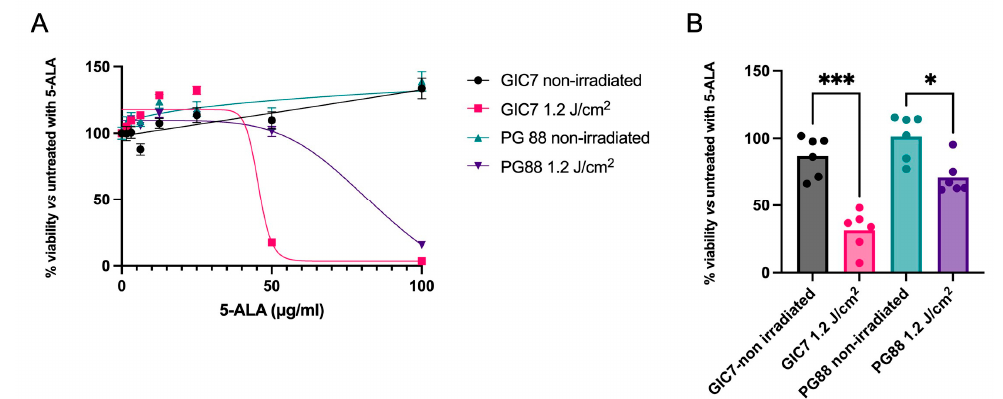
Figure 7. Comparison of GIC7 and PG88 cells’ behavior under 5-ALA treatment (0–100 µg/mL) and irradiation. ( A ) Dose-response comparison of adherent cell cultures with different 5-ALA concentrations treated with 1.2 J/cm 2 irradiation. ( B ) Cell viability comparison between GIC7 and PG88 tumorspheres under 5-ALA 50 µg/mL and 1.2 J/cm 2 irradiation. Results are representative of three independent experiments ( n = 3) performed in triplicate. * p value < 0.05; *** p value < 0.005.